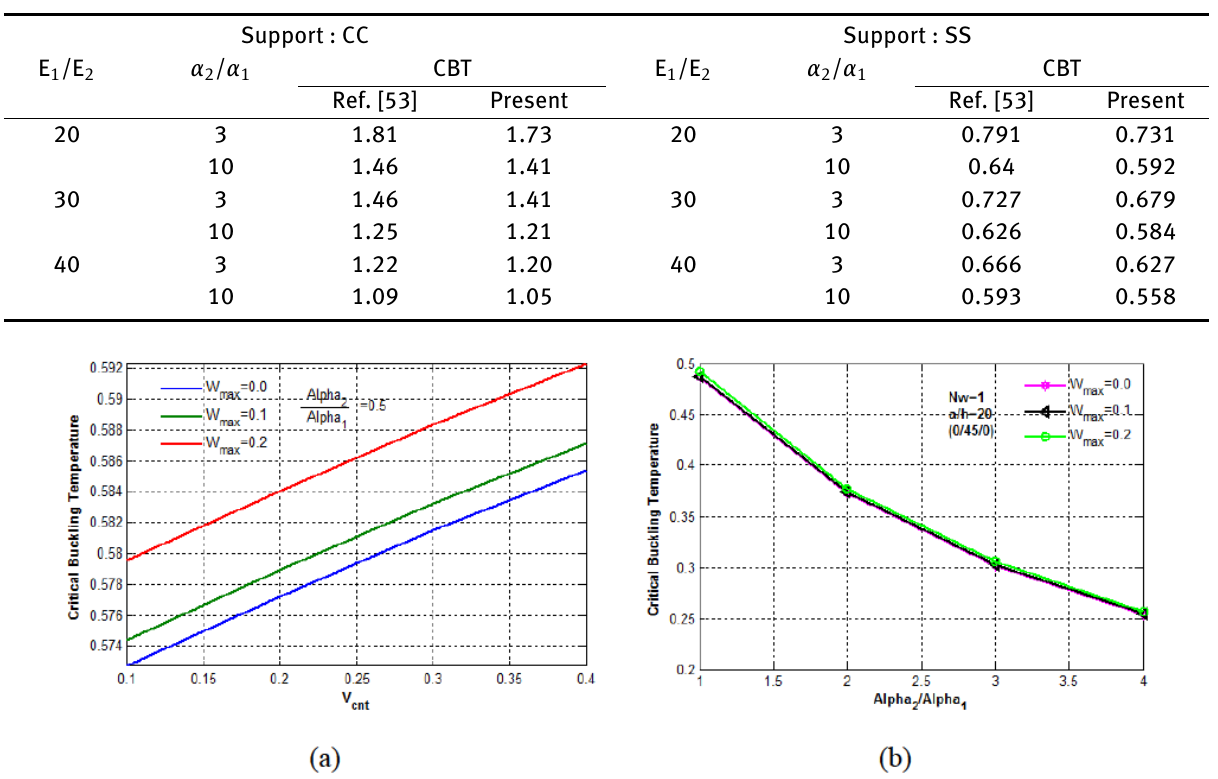
Table 8: Effect of elasticity ratio and CTE on CBT under different support conditions Support : CC